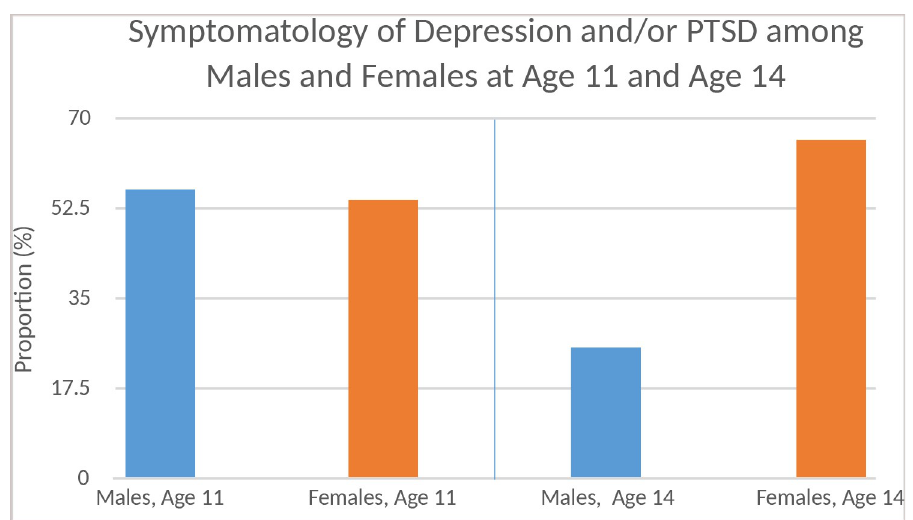
https://doi.org/10.1371/journal.pone.0224499.g002